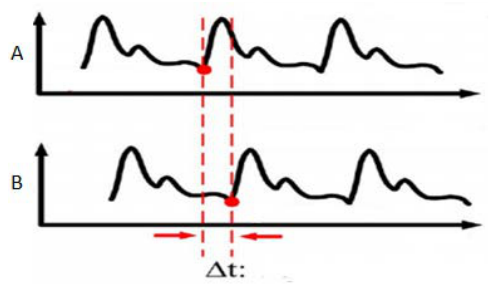
Figure 3. Measurement of the pulse wave delay time.